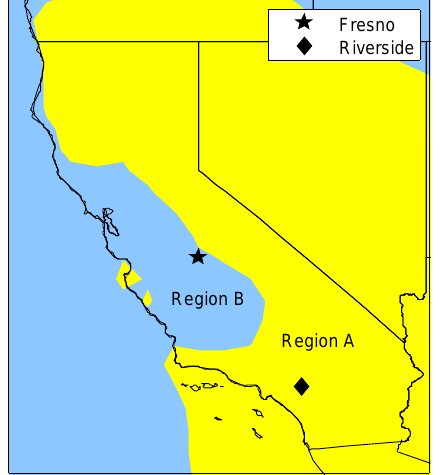
Fig. 11. California regions of high (Region A) and low (Region B) ammonia sensitivity in predicted nitrate. Region A (yellow areas in California) comprises the grid points for which predicted 2009 annual nitrate concentrations increase by 60% or more above the base case when ammonia emissions are doubled in GEOS-Chem. Region B (blue areas in California) comprises the grid points for which predicted 2009 annual nitrate concentrations increase by less than 60% when ammonia emissions are doubled in